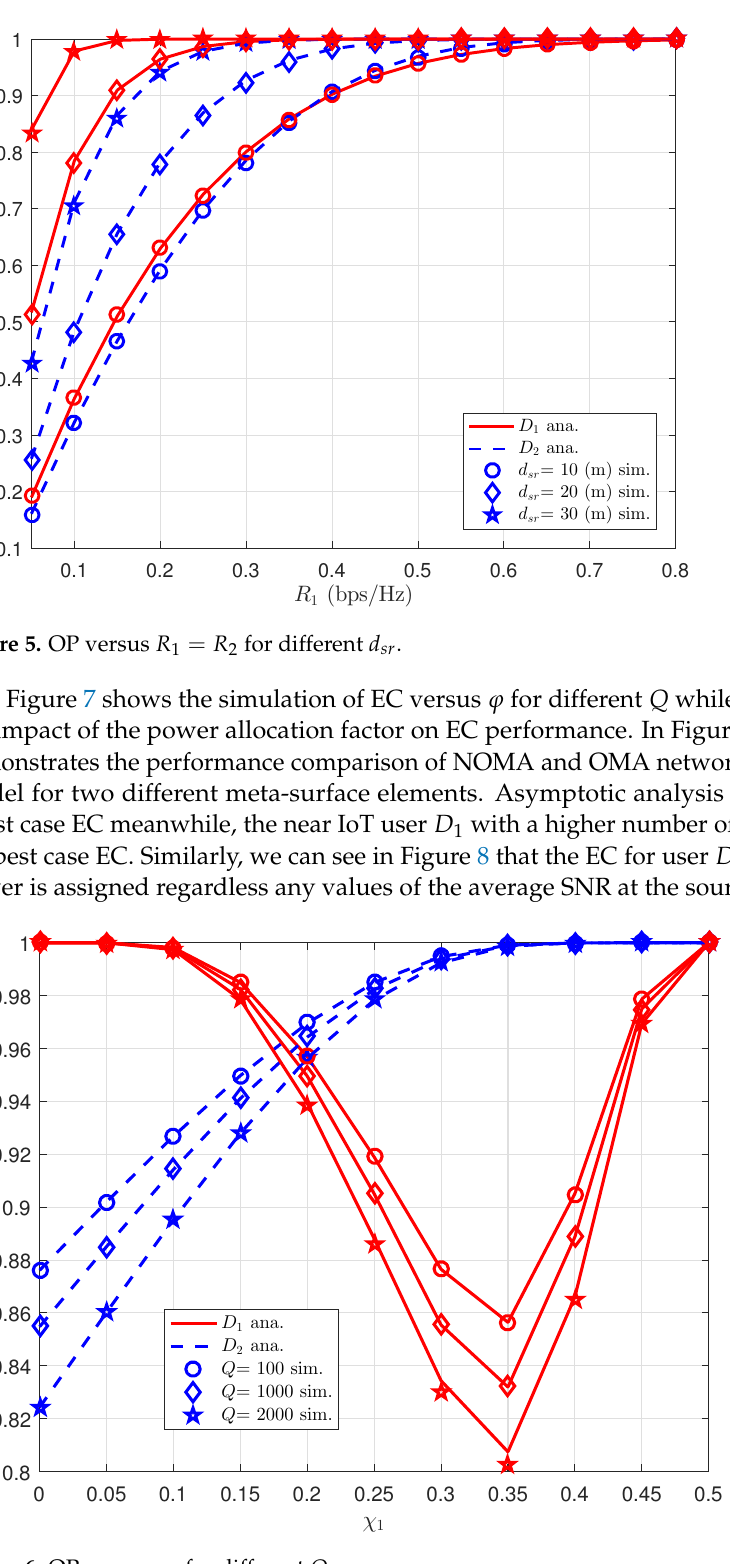
Figure 6. OP versus χ 1 for different Q